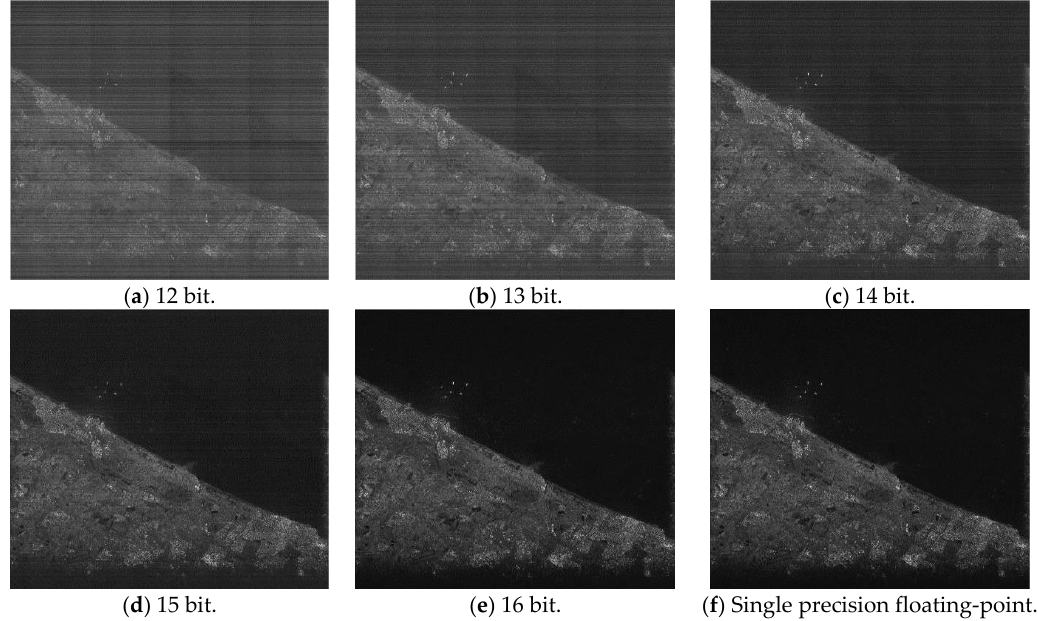
Figure 5. Actual scene imaging results (overall region) for different FFT processing accuracies. ( a – e ): 12- to 16-bit fixed-point FFT, ( f ) single precision floating-point FFT.